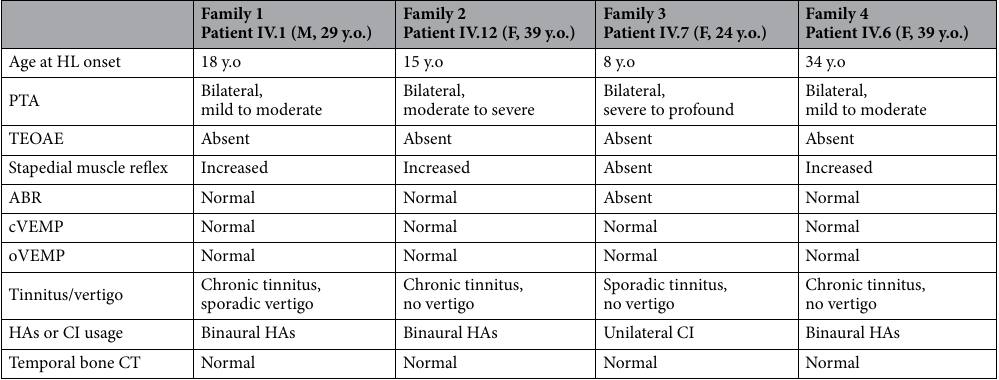
Table 1. Results of objective audiological, neurotological and imaging examinations of probands with TBC1D24 -related ADHL. ABR auditory brainstem responses, CI cochlear implant, CT computed tomography, cVEMP cervical vestibular evoked myogenic potentials, F female, HAs hearing aids, M male, oVEMP ocular vestibular evoked myogenic potentials, PTA pure tone audiometry, TEOAE transient evoked otoacoustic emissions, y.o. years